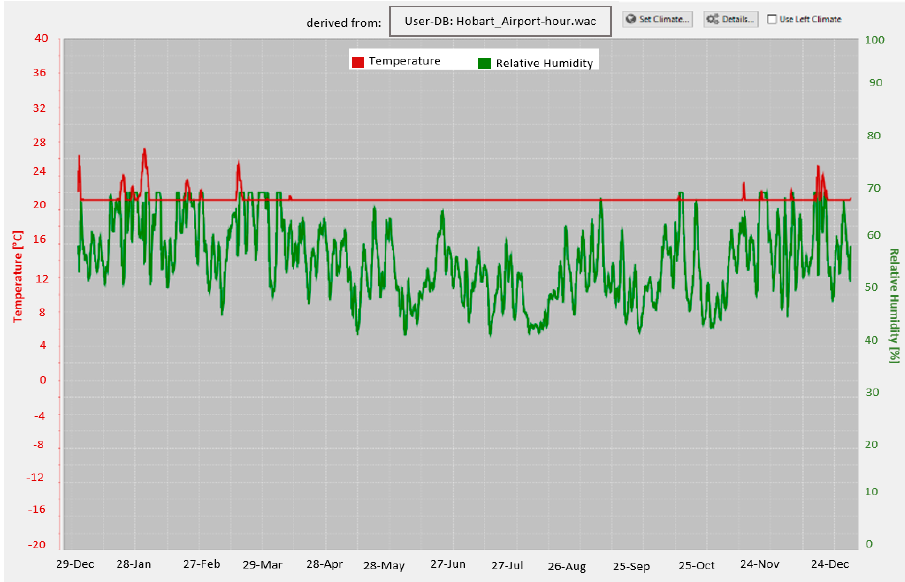
Figure 4. Graph showing the interior temperature and relative humidity profiles for EN − 15026, DIN − 4108, and WTA6 − 2.